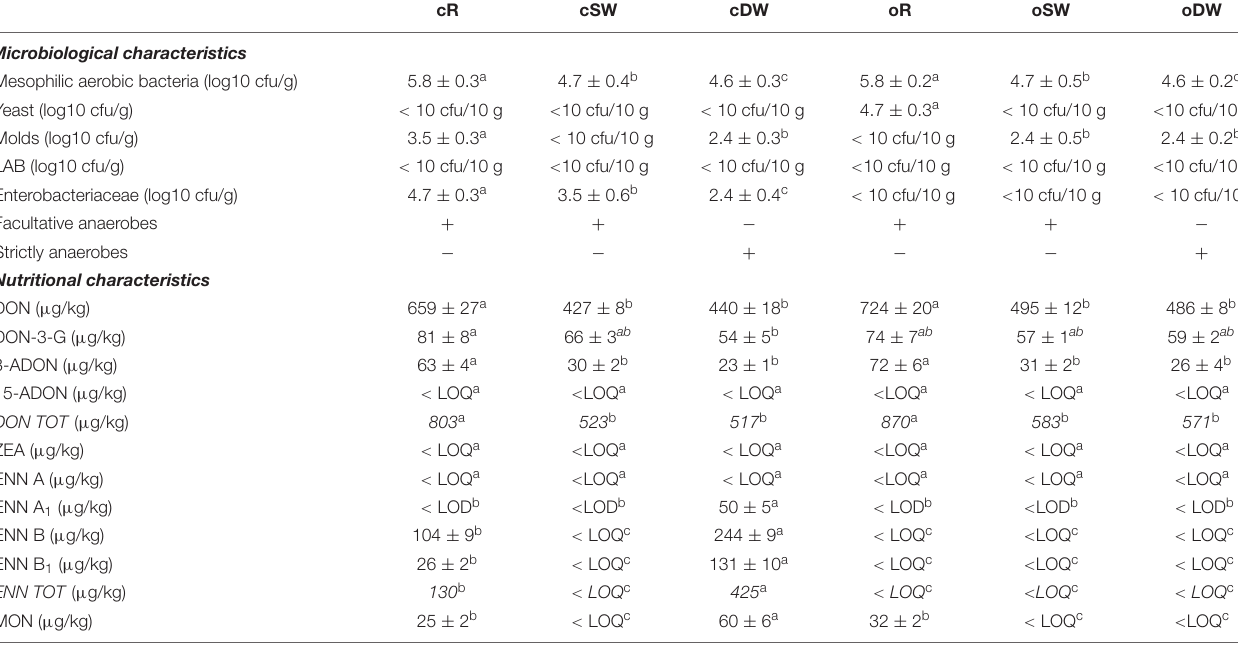
TABLE 1 | Nutritional and microbiological characterization of conventional and organic rye, soft, and durum wheat used in this